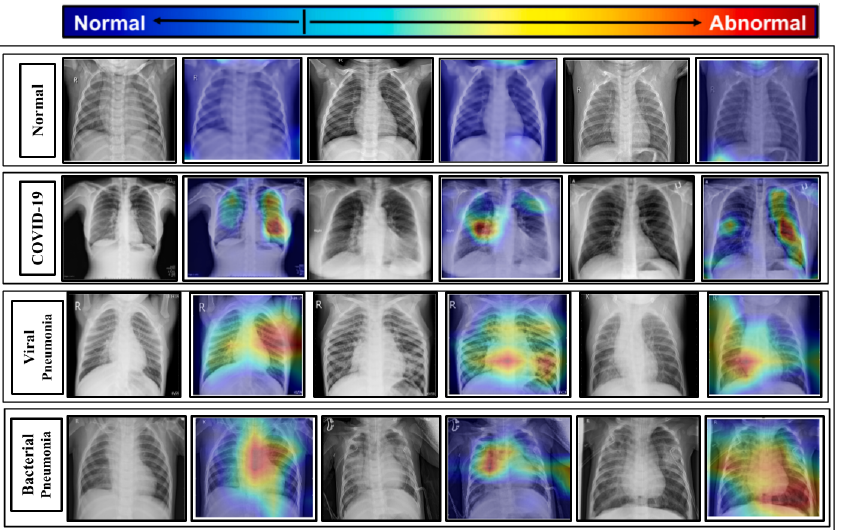
Figure 13. Significant portions of the test chest X-rays that induce the decision are localized by imposing the class activation heatmap obtained from the proposed